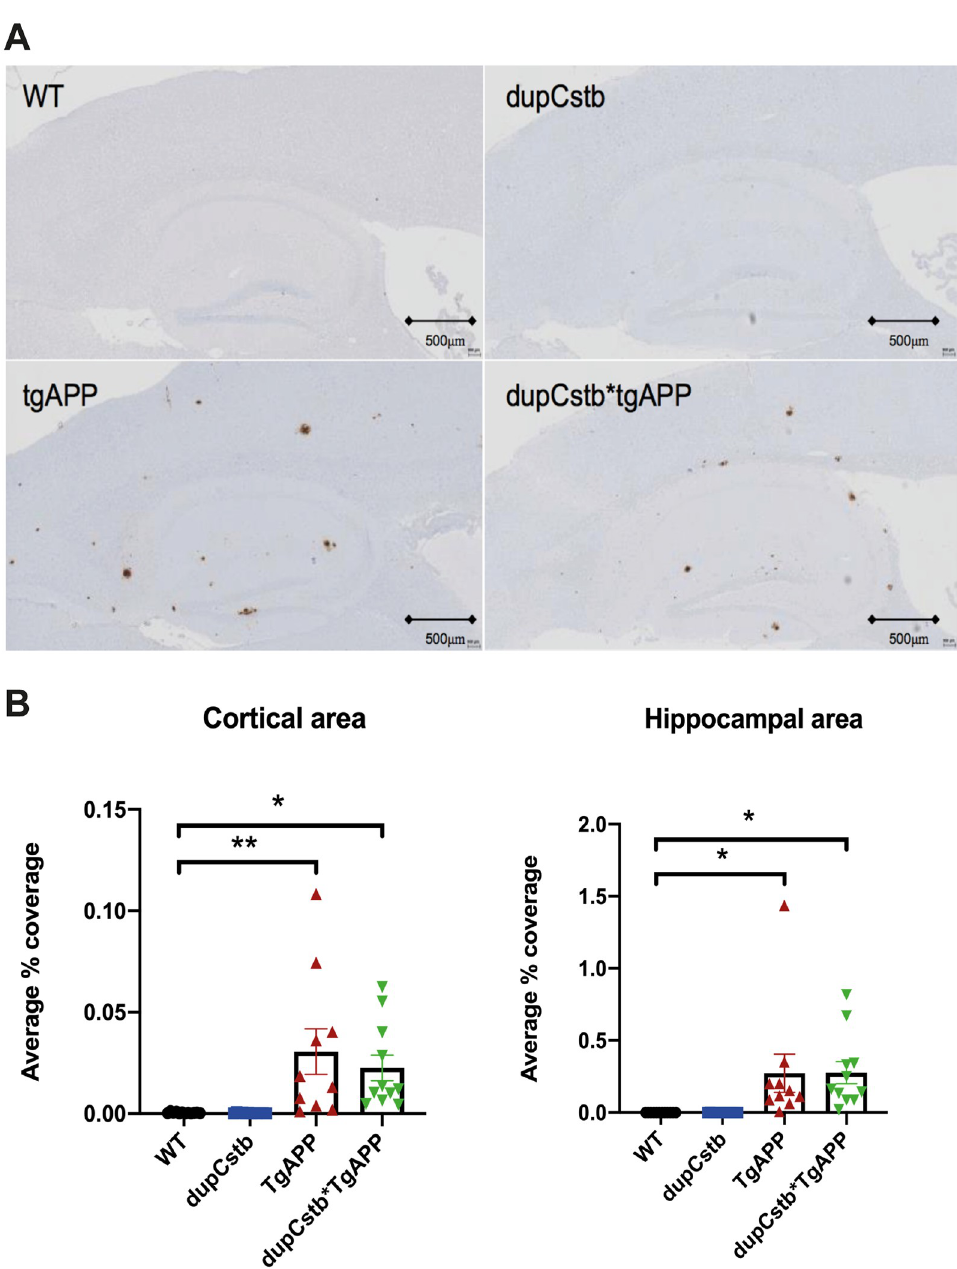
Fig 2. A β plaque deposition in the cortex and hippocampus of 6-month old mice. (A) Representative images of sagittal sections through the cortex and hippocampus. (B) Area stained with 4G8 antibody (brown) to A β was quantified as a percentage of the total area of that region, and group means ± SEM are presented (n = 10–12 per genotype, 23 females and 22 males used in total). Mice with tgAPP had significantly more A β staining than those without, in the cortex (F (1,37) = 19.503, p < 0.001) and hippocampus (F(1,37) = 14.466, p = 0.001). There was no significant effect of Cstb duplication or sex, and no interaction between tgAPP and dupCstb. Data were analysed using a repeated measures ANOVA. Bonferroni post-hoc pair-wise comparisons p < 0.05 = � , p < 0.01 = �� .